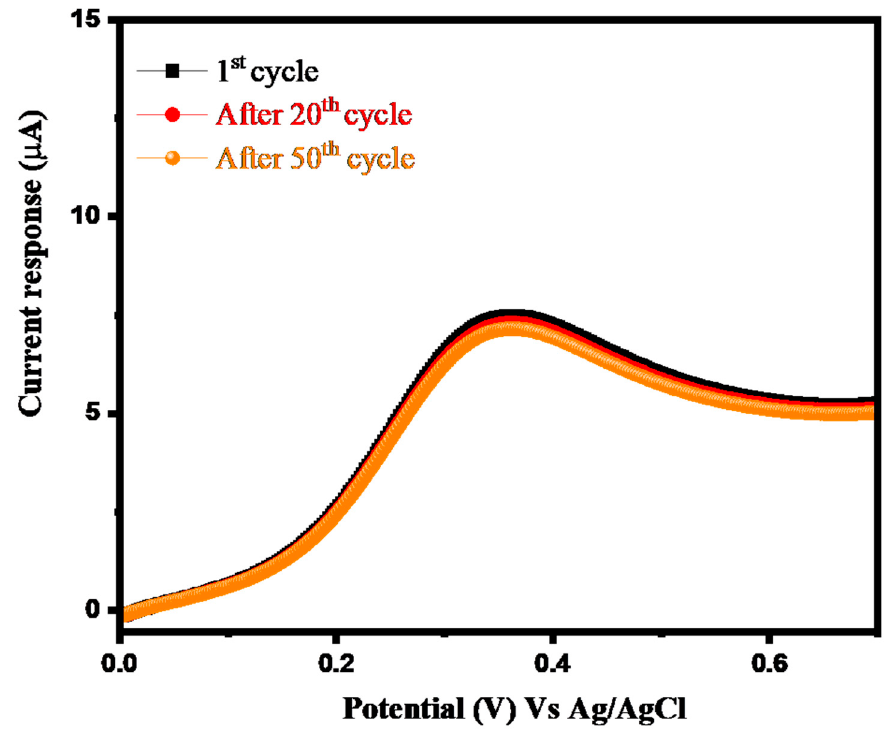
Figure 11. LSV responses (1st, 20th, and 50th) of NiO-GE for 5 ppb As 3+ (0.1 M PBS of pH = 6) at scan rate = 50 mVs − 1 .